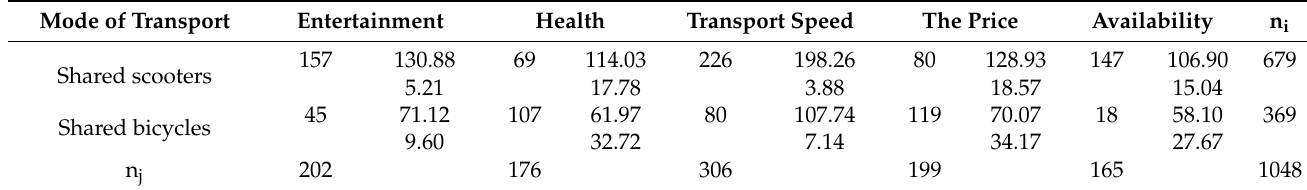
Table 4. Dependence of the reason for using the application on the type of transport.